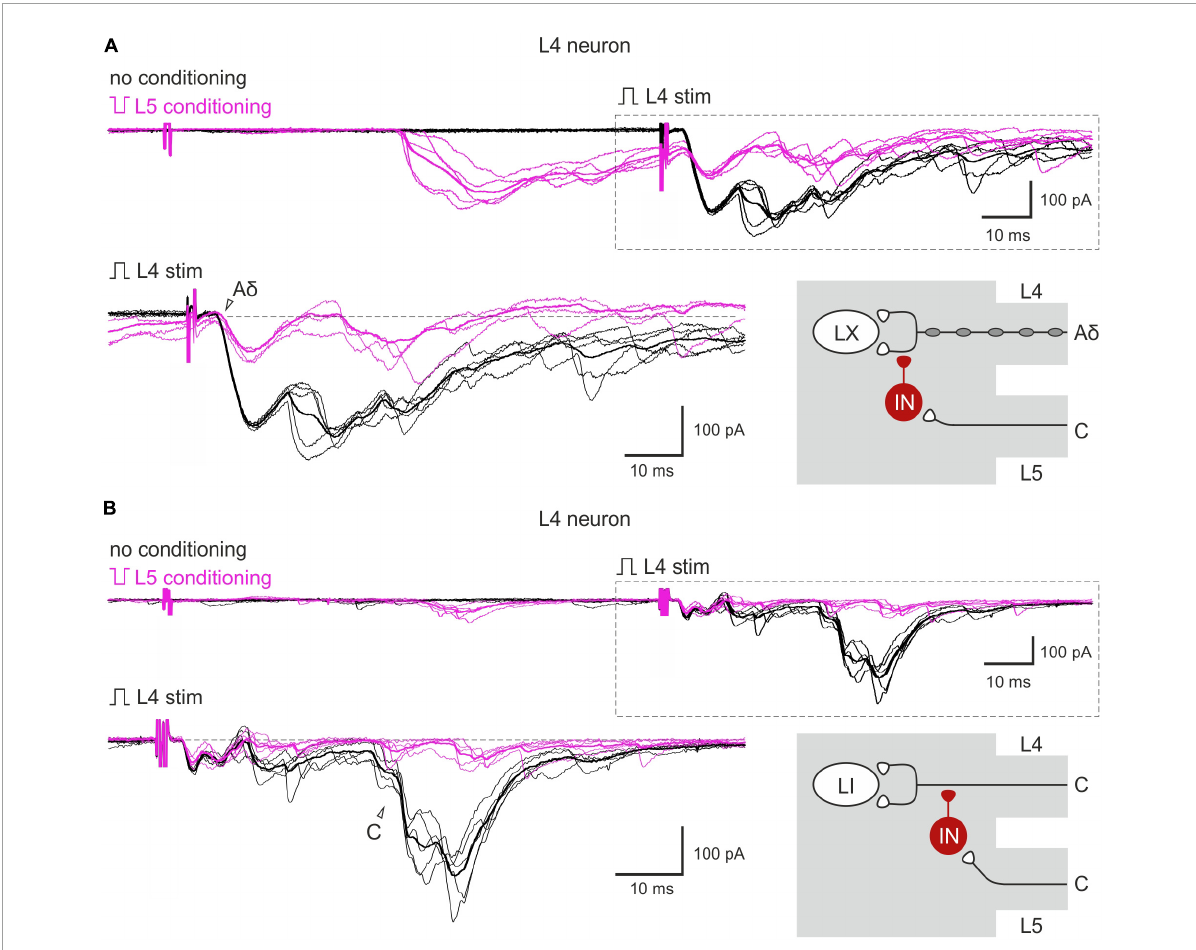
FIGURE3 Heterosegmental AD-PI: the L5 C-fibers control the L4 afferent input. The L5 C-fibers induced inhibition of the L4 primary afferent inputs to the L4 spinal neurons. Excitatory postsynaptic currents (EPSCs) were evoked by the L4 root stimulation (normal pulse) in control (black) and after conditioning (100 ms interval) L5 root stimulation (inverted pulse) activating only C-fibers (magenta). The heterosegmental C-fiber conditioning induced a partial (A) or full (B) suppression of the monosynaptic A δ - and C-fiber-mediated components of EPSCs (open arrowheads). Individual and averaged (bold) traces are shown. Traces in the insets are shown below at higher magnification and with membrane currents before EPSC initiation set to the same level. Putative schematics of AD-PI given on the right are valid for both lamina I and X neurons. IN, inhibitory interneuron; LI, lamina I neuron; LX, lamina X